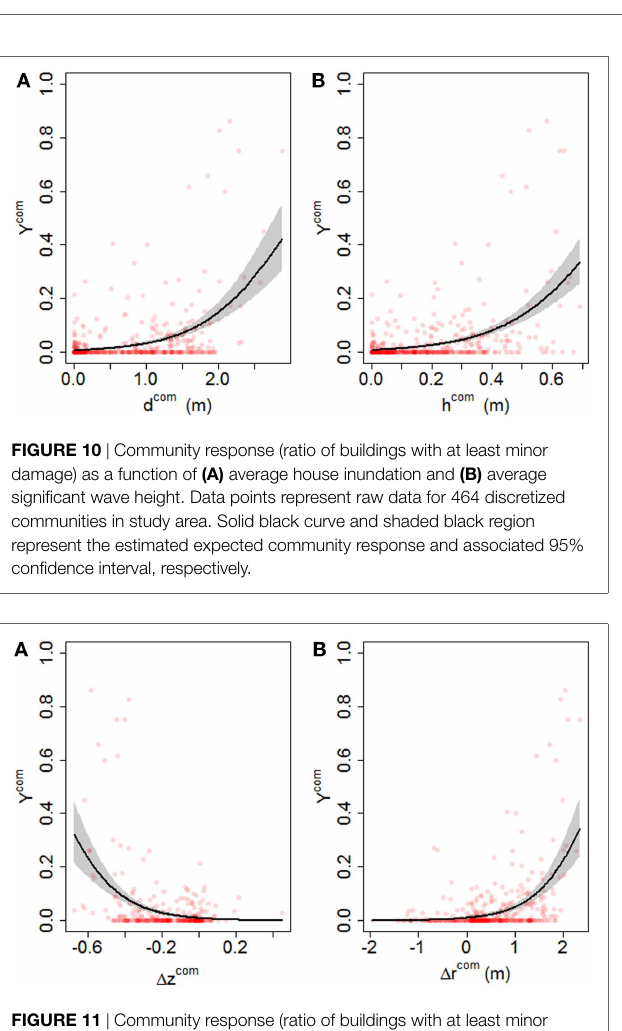
FIGURE 11 | Community response (ratio of buildings with at least minor damage) as a function of the (A) percent change in dune height and (B) average relative inundation to community performance. Data points represent raw data for 464 discretized communities in study area. Solid black curve and shaded black region represent the estimated expected community response and associated 95% confidence interval,